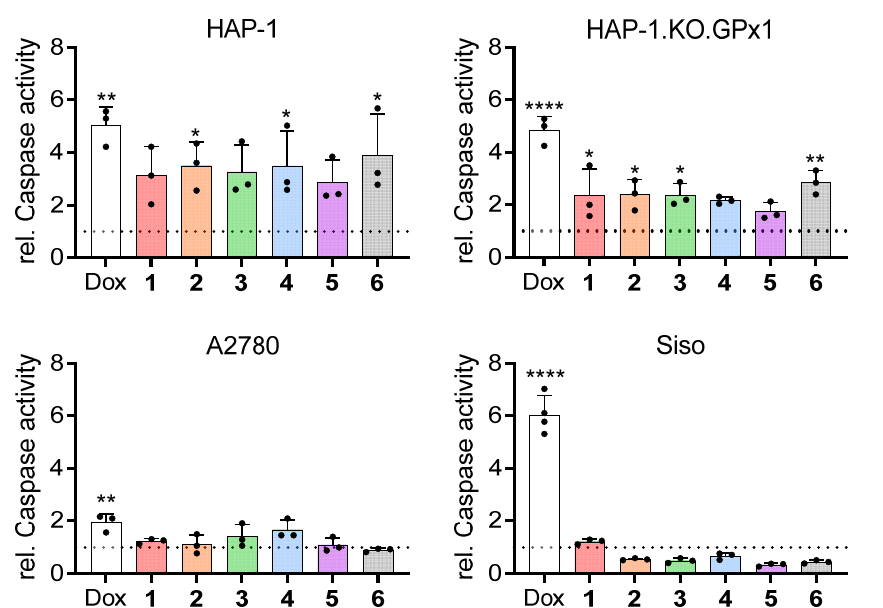
Figure 16. Activation of caspase-3 and -7 in HAP-1, HAP-1.KO.GPx1, A2780, and Siso after treatment for 24 h with the respective pentathiepins 1 – 6 (IC 90 ) or 0.5 µM doxorubicin (Dox) as positive control in relation to an incubation with the solvent DMF. Statistical analysis was performed with Prism 7 by one-way ANOVA and Dunnett’s multiple comparisons post hoc test. n = 3 independent experiments. * p < 0.05, ** p < 0.01, **** p < 0.0001.